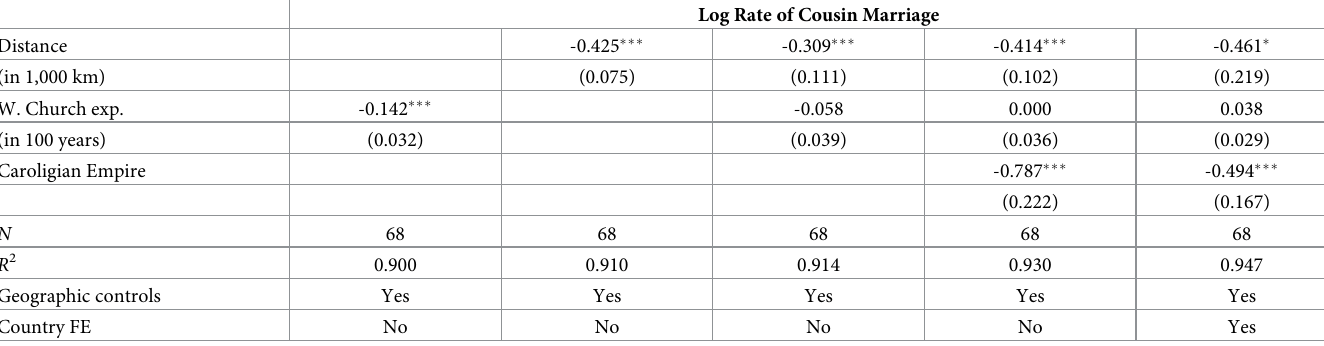
Table 2. Region-level regressions of cousin marriage on distance to innovation and Church